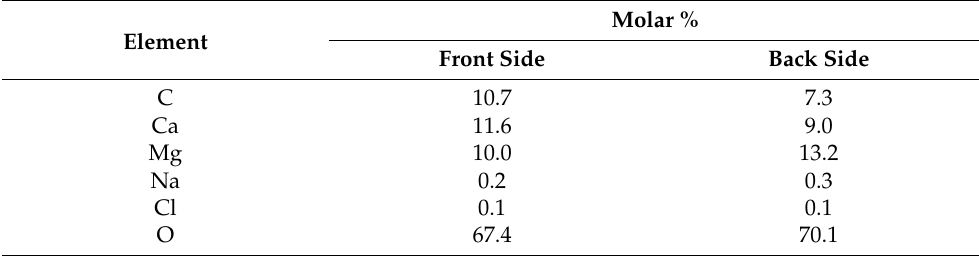
Table 4. Medium composition of the solid deposited on both faces of the cathode during 3 different EE assays. Solution S; I = 0.1 A; Anode—BDD 20 cm 2 ; Cathode—SS 20 cm 2 ; Stirring speed 1000 rpm.